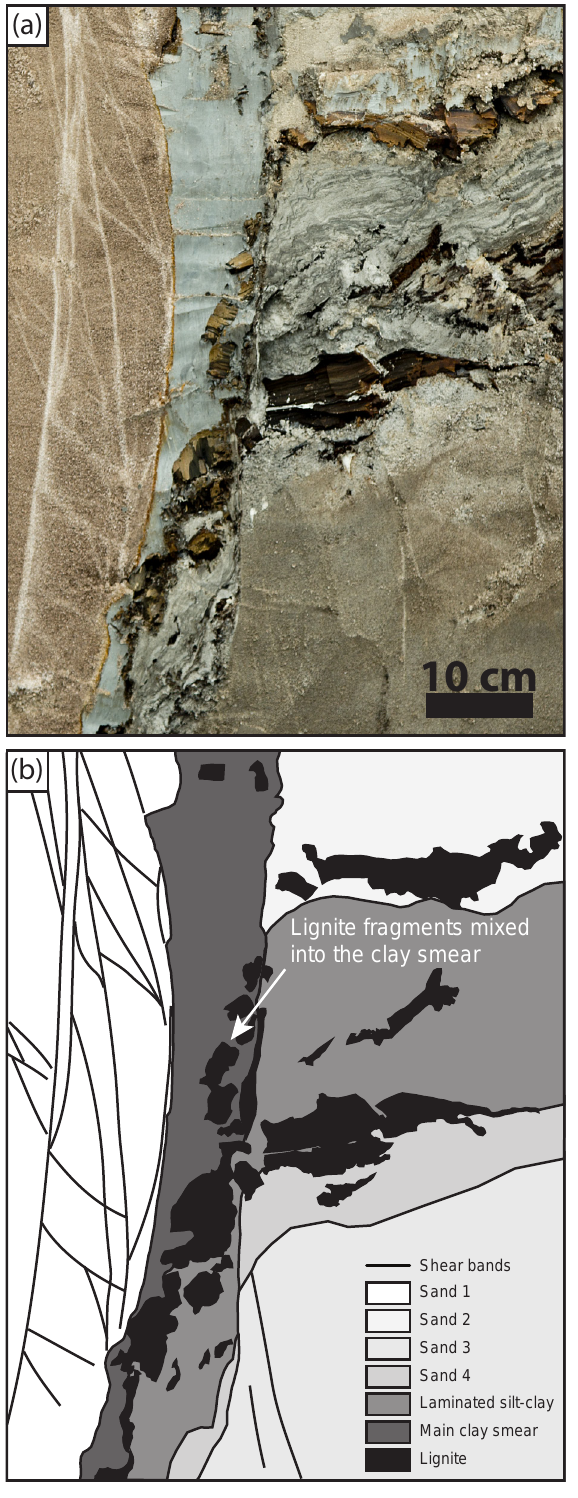
Figure 20. (a) Vertical cross section on the fifth floor of the Ham- bach mine documented during a different field campaign. Fault, rough location and elevation correspond to outcrops in this paper. (b) Interpretation showing brittle lignite fragments transported into clay smear. Fragments appear aligned within clay smear.